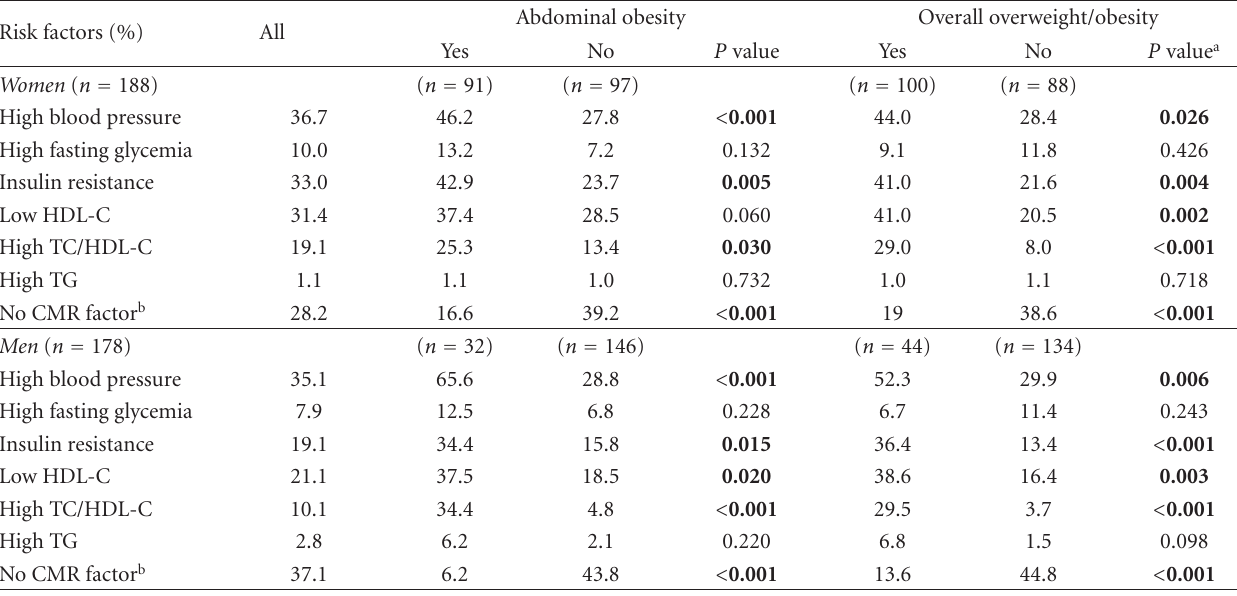
Table 3: Evolution of prevalence of cardiometabolic risk factors during the four-year followup period ( n = 366).